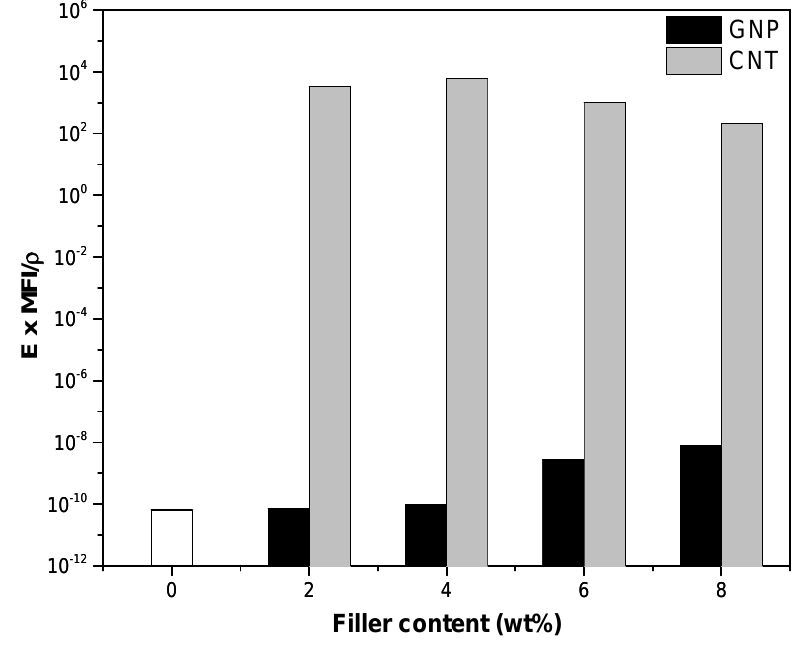
Figure 14. Comparison of parameters P E,M, ρ (250 °C) combining the effects of elastic modulus, melt flow index at 250 °C and resistivity as a function of nanofiller fraction up to 8 wt %.